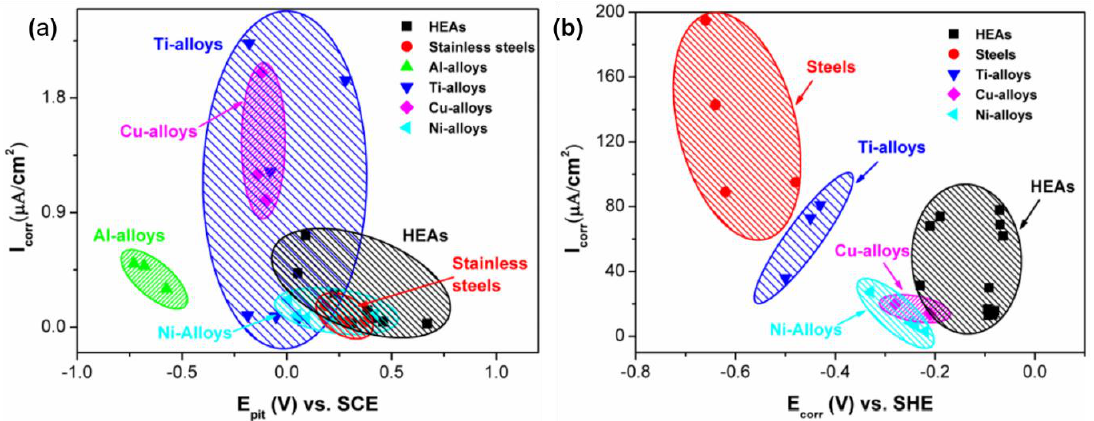
Figure 12. A comparison of the corrosion current density ( i corr ) and pitting potential ( E pit ) between HEAs and other materials at room temperature. ( a ) In the 3.5 wt. % NaCl solution. ( b ) In the 0.5 M H 2 SO 4 solution [ 82 ] .